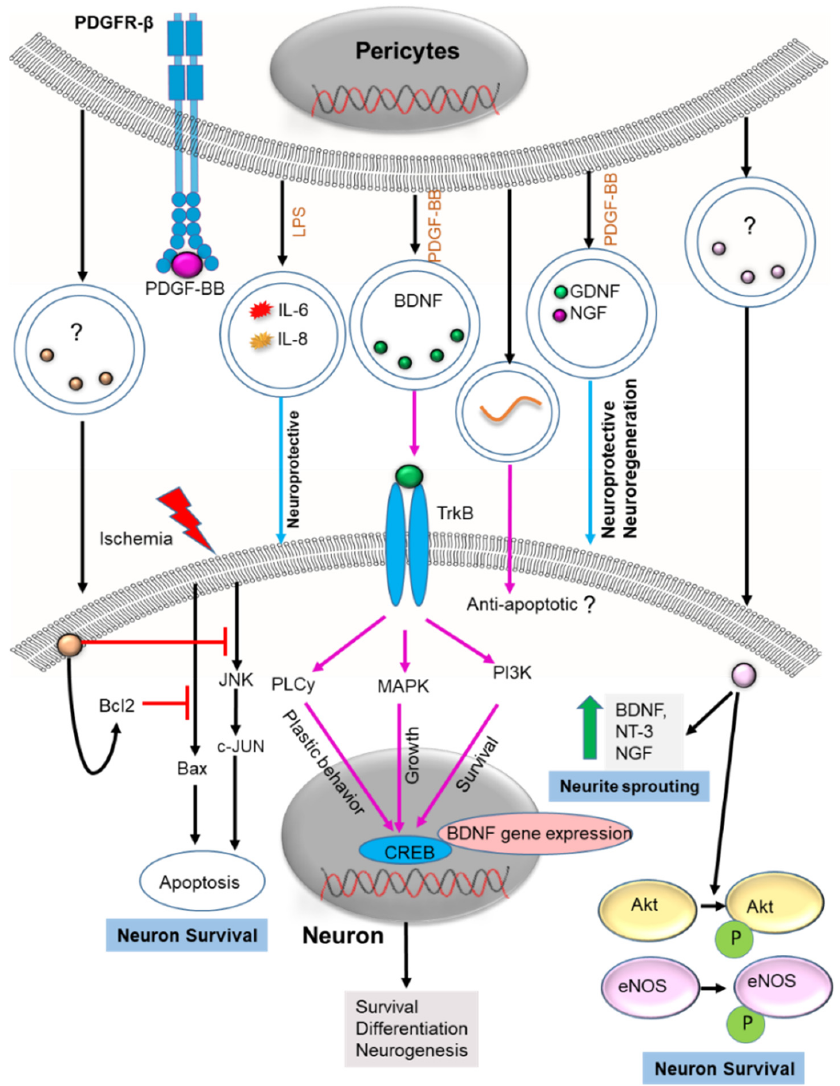
Figure 4. Postulated mechanisms of PC-EVs in neuroprotection and neurogenesis. In response to PDGF-BB, PC-EVs release BDNF to recipient neurons. BDNF targets TrkB receptors and activates PLC γ , MAPK, and PI3K pathways to promote plasticity, growth, and survival. These pathways target CREB transcription factors, enhancing BDNF gene expression and promoting survival, differentiation, and neurogenesis. PC-EV release of growth factors such as GDNF, PTN, and NGF also protects against neurodegenerative pathology. PC-EVs enhance the expression of BcL2 for survival and inhibit both Bax apoptosis and the JNK/jun-c cell death pathway, thus promoting neuronal survival. PC-EVs released from pericytes also increase the expression of growth factors, including BDNF, NT-3, and NGF, which encourage neurogenesis. PC-EV phosphorylated Akt and eNOS promote neuronal survival. “?” indicates the content of the PC-EVs is not identified. Various miRNAs transferred to neurons may also promote neuronal survival and neurogenesis. “?” means the pathway is unknown. The black arrow indicates identified mechanism, the magenta arrow indicates the hypothesized Mechanism in PC-EVs based on the mechanism identified in other EVs, and the blue arrow indicates the speculative mechanism (miRNA: an acronym for micro RNA; PCs: pericyte; EVs: extracellular vesicles; BDNF: Brain-derived neurotrophic factor; NGF: nerve growth factor; GDNF: Glial cell-derived neurotrophic factor; NT-3: Neurotrophin-3; JNK: c-Jun N-terminal kinase; MAPK: Mitogen-activated protein kinase; PI3K: Phosphoinositide 3-kinase; eNOS: endothelial nitric oxide synthase; TrkB: Tropomyosin receptor kinase B; PDGF: Platelet-derived growth factor).